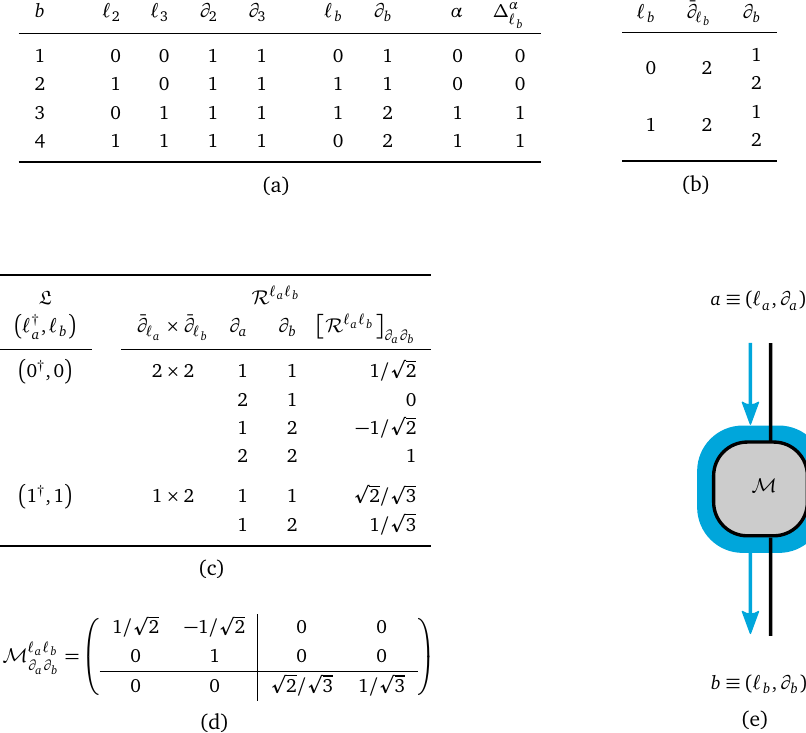
Figure 19: Symmetric link fusion ( (cid:96) links in the tensor T mapping in detail; b is the linear index in column-major enumeration of (cid:96) The collision index α and the corresponding degeneracy offset ∆ α algorithm of Sec. 3.5.1 to place degeneracy indices of pairs (cid:96) same (cid:96) into successive intervals ∆ α b